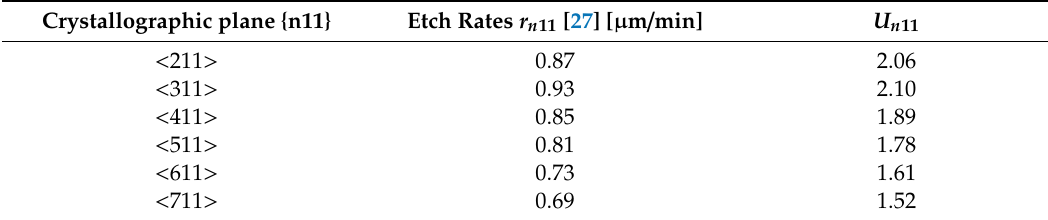
Table 3. The values of etch rates and ratios of undercut and etch